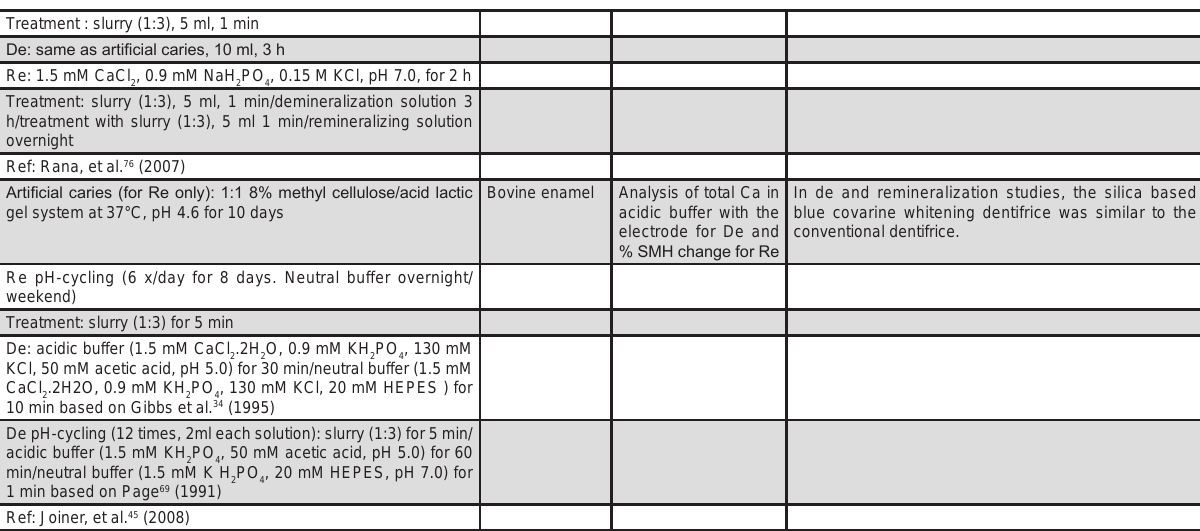
Figure 5- pH-cycling studies comparing the impact of new active principles on the anti-caries efficacy of fluoride dentifrices PROTOCOL DENTAL TISSUE R E S P O N S E pH-cycling (3d at 37°C): Human dentin SMH The cariostatic effect shown by fluoride-containing dentifrice De: (1h) 2 mM Ca, 2 mM phosphate, acetate 74 mM, pH 4.3